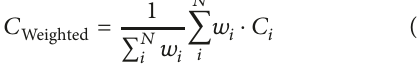
several examples, mainly because the detector is not trained to handle non-frontal